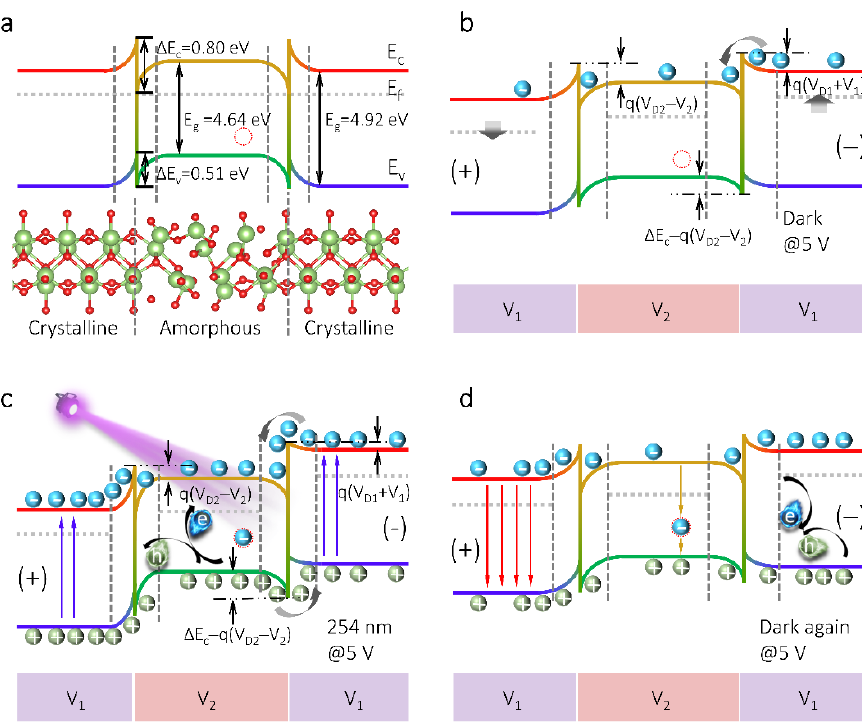
Figure 5. Energy band diagram and carrier transport process of amorphous/crystalline mixed-phase Ga 2 O 3 PD at different conditions: ( a ) after contact without bias, ( b ) under bias in dark, ( c ) under bias with 254 nm DUV illumination, and ( d ) in dark again after photoexcitation.